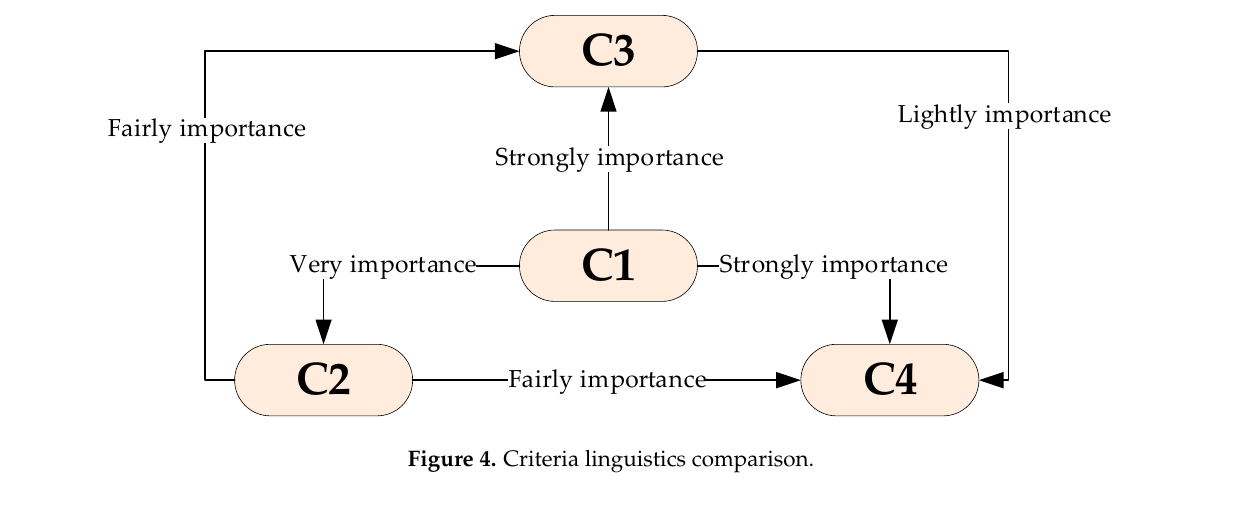
Table 8. Main criteria non-fuzzy comparison matrix.